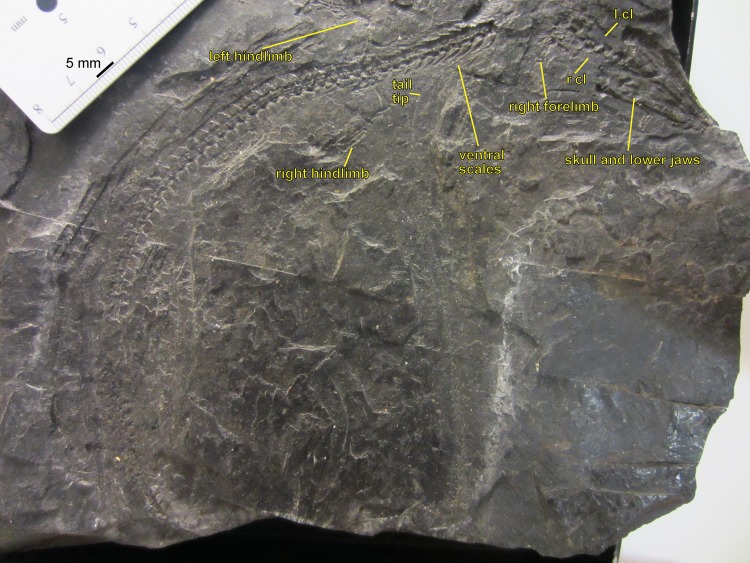
NHMW 1983/32/11, a natural mold of an articulated skeleton referred to Sauropleura scalaris.Abbreviations: l.cl, left clavicle; r.cl, right clavicle. Photo taken by D. M.